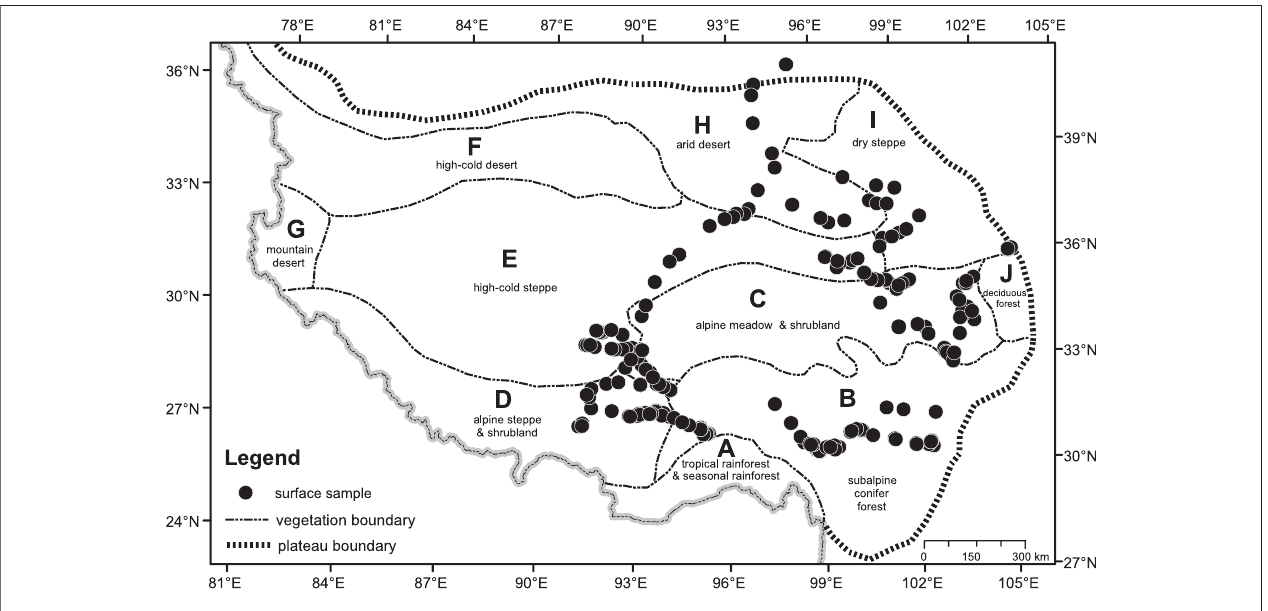
FIGURE 1 | The vegetation of the TP and location of surface samples.